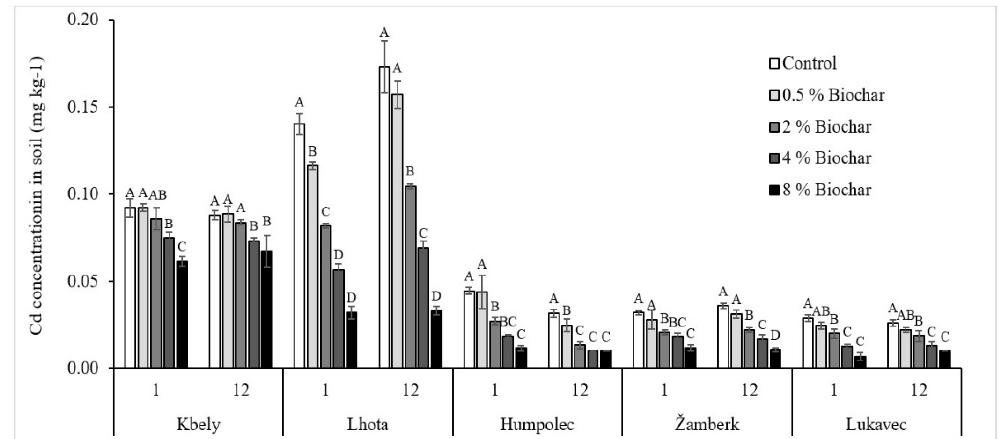
Figure 5. Effect of biochar addition on soil-available content of Cd (mg kg − 1 ). On the horizontal axis, 1 and 12 stand for 1st and 12th week of incubation period or sample collection time, respectively. Di ff erent capital case letters represent significance di ff erence ( p < 0.05) of treatments within same sample collection time of same soil. Table 8. Pearson correlation coe ffi cient of available Cd content with soil pH, CEC, and exchangeable Ca 2 + and K + after addition of four levels of biochar (0.5%, 2%, 4%, and 8%) at the 12th week of incubation. Cd ( n =